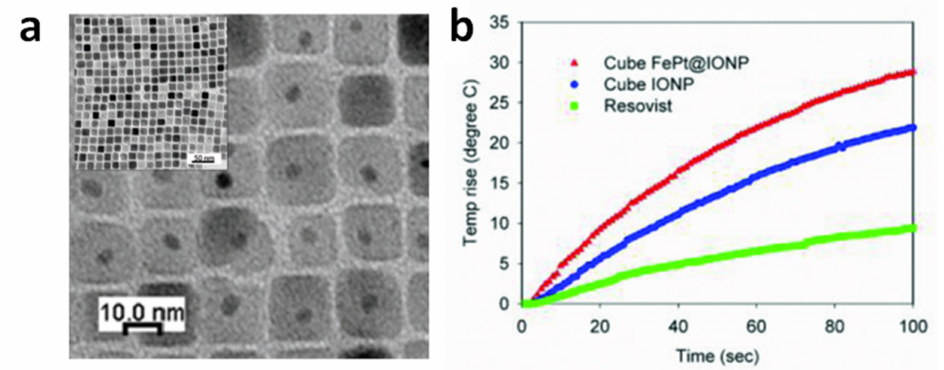
Figure 3. ( a ) Transmission electron microscopy (TEM) image of CS_NPs composed of a spherical FePt core embedded in a cube of Fe 3 O 4 . ( b ) Heating curves measured on the CS_NPs (sample FePt@IONP) and, for comparison, on single-phase magnetite cubic NPs (sample IONP) and on commercial iron oxide NPs (Resovist). Resovist and IONP showed SAR values of 0.39 and 0.92 kW/g, respectively, while the CS_NPs exhibited a value of 1.21 kW/g (AMF of 18.8 kA/m and 630 kHz). Adapted from Ref. [127] under CC BY_NC 4.0 International